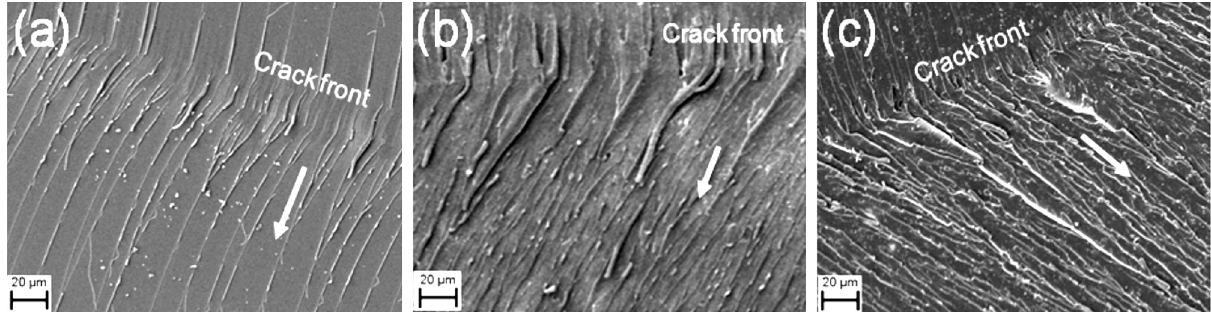
Figure 9. Fracture surfaces of specimens after fracture toughness testing ( a ) neat epoxy; ( b ) 0.2 wt.% APTS-GO/epoxy nanocomposites; and ( c ) 0.2 wt.% GPTS-GO/epoxy nanocomposites. The white arrows indicate the direction for crack propagation. APTS-GO/epoxy = 3-aminopropyltrimethoxysilane-functionalized graphene oxide/epoxide; GPTS-GO/epoxy = 3-glycidoxypropyltrimethoxysilane-functionalized graphene oxide/epoxy. Reprinted with permission from [114] . 2013, Elsevier.